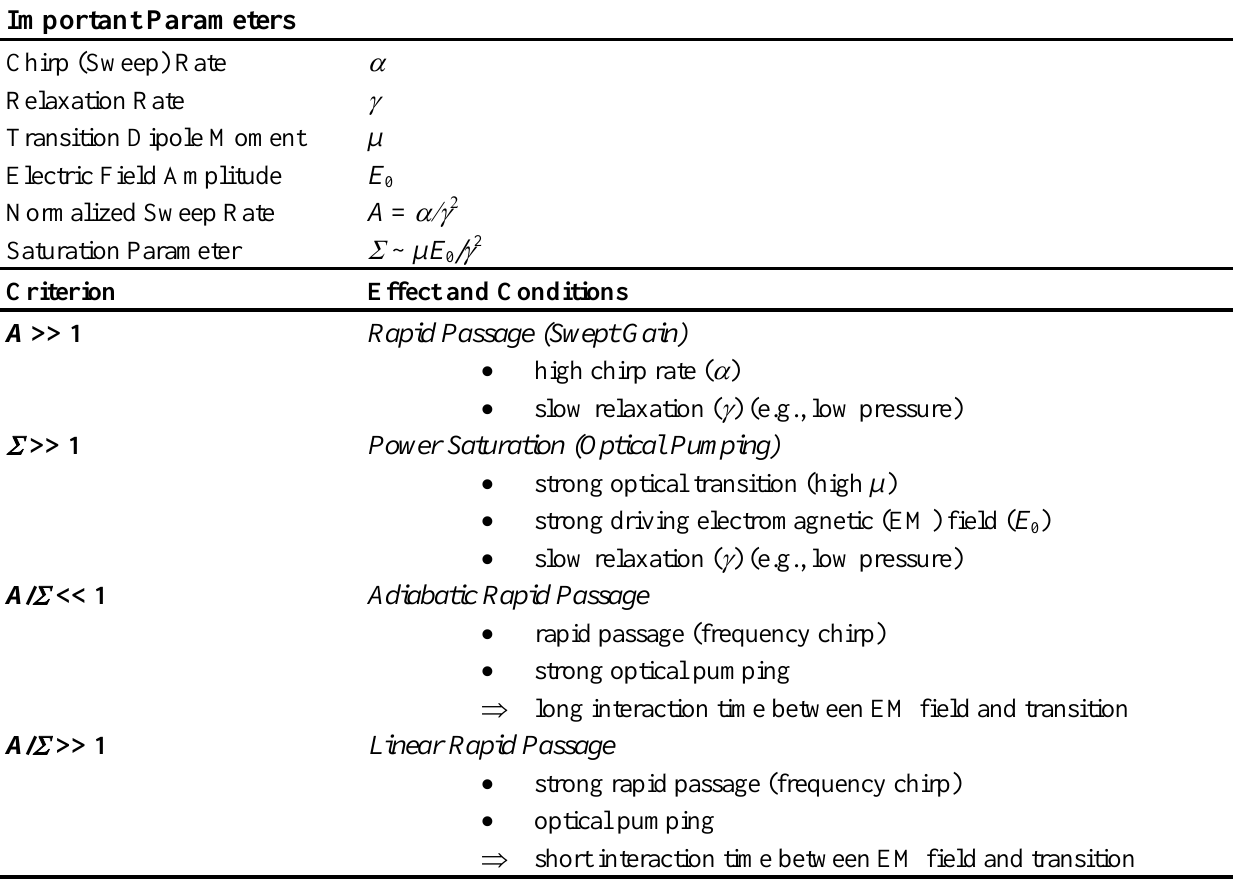
Table 1. Summary of potential non-linear absorption effects that might be observed with pulsed QCLs. Important